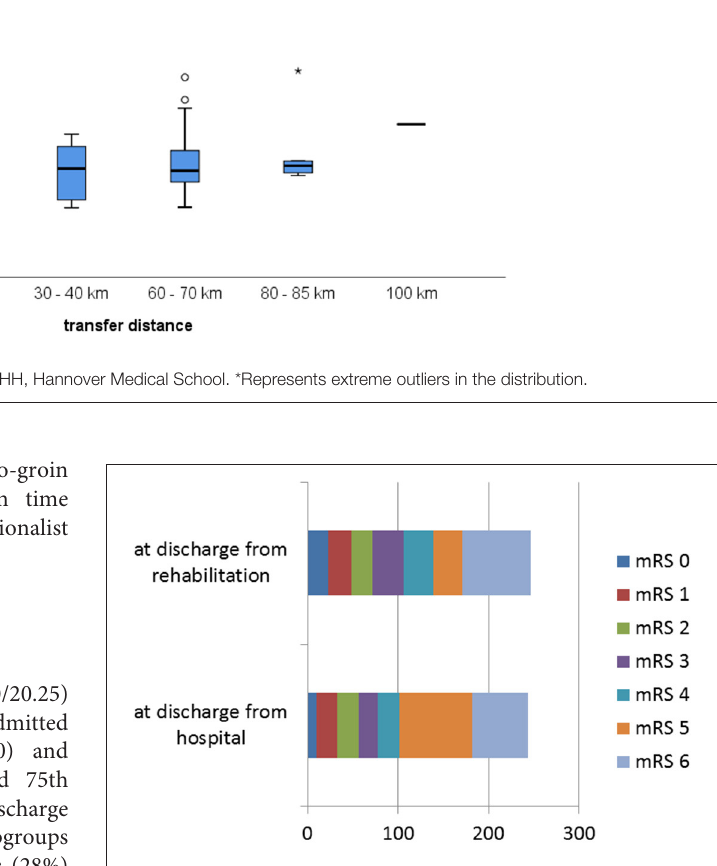
FIGURE 3 | Modified Rankin Scale (mRS) at discharge from hospital and after inpatient rehabilitation for n = 246 patients for whom data at both time points were